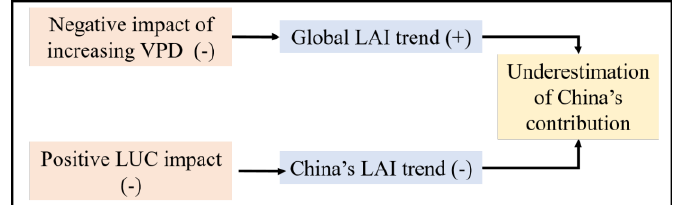
Figure 8. A schematic diagram of the underestimation of China ’ s contribution to global greening by terrestrial ecosystem models during the period of 1999 – 2012. On the one hand, the negative effect of a rapid increase in VPD on global LAI trends was underestimated by terrestrial ecosystem models. On the other hand, the positive impact of afforestation in China has been underestimated or ignored in the terrestrial ecosystem model. These have led to an underestimation of China ’ s contribution to global greening. Symbols (+ or -) indicate an increase or decrease in the variable ’ s effect on the increasing trend of LAI, respectively.